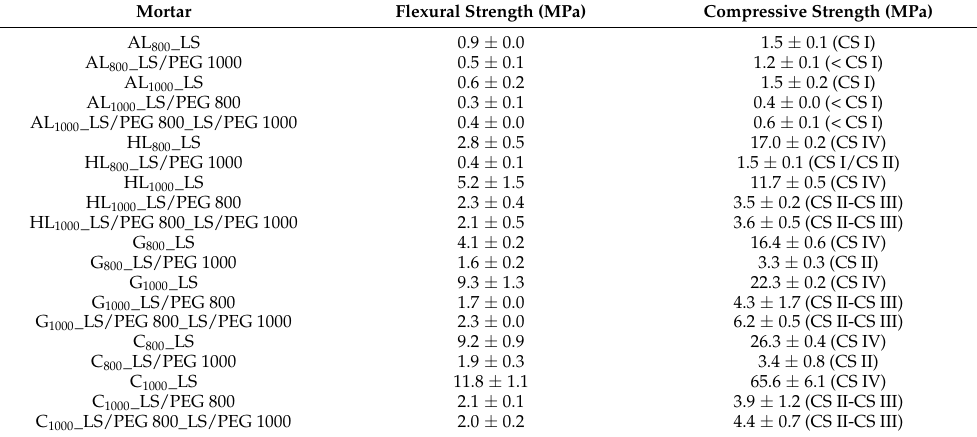
Table 4. Mechanical properties of the mortars whose compositions are reported in Table 1 measured in flexural and compressive mode. (The category of mechanical strength of the mortars according to the NP EN 998-1 standard is shown in brackets.) Mortar Flexural Strength (MPa) Compressive Strength (MPa) AL 800